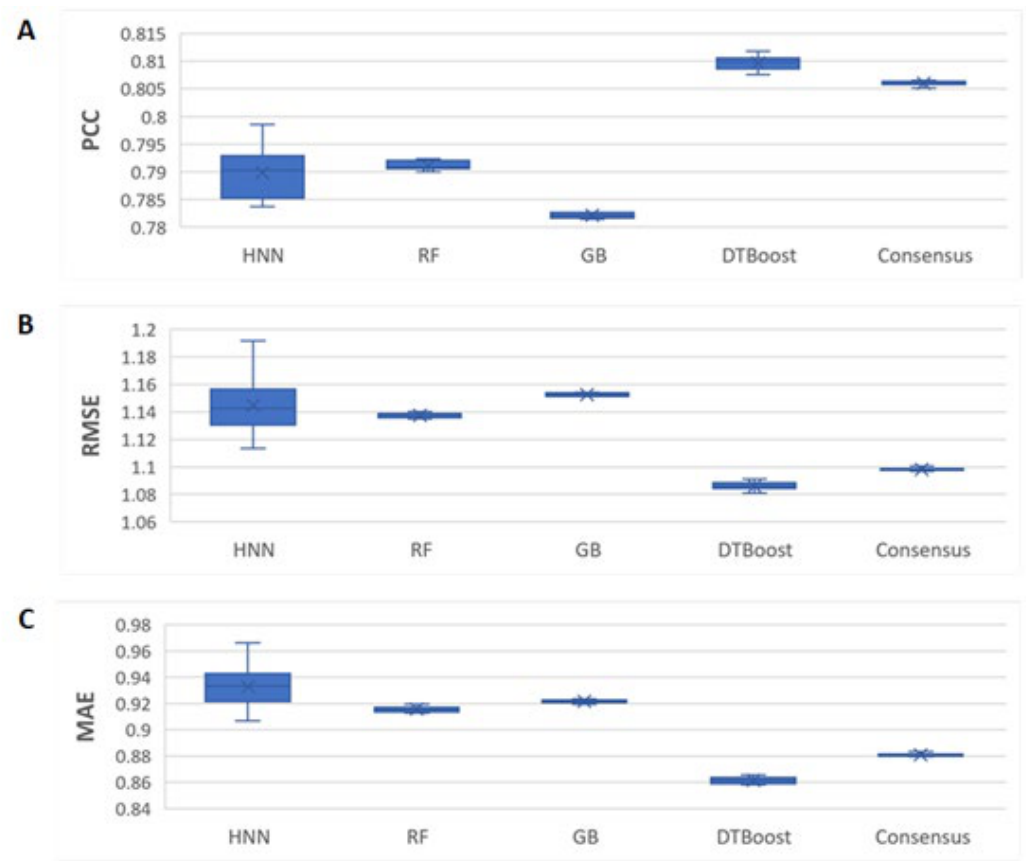
Figure 7. The HNN-denovo performance comparison to other models for the refined general set binding data. ( A ) PCC, ( B ) RMSE, and ( C ) MAE of the binding affinity prediction by the HNN, RF, GB, DT, and consensus methods.